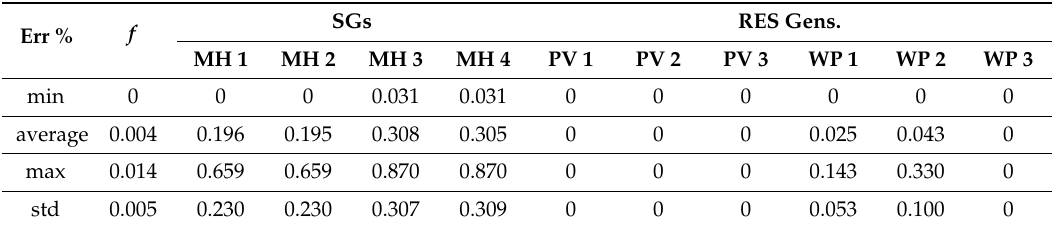
Table 8. Optimization against dynamic simulations comparison: high generation